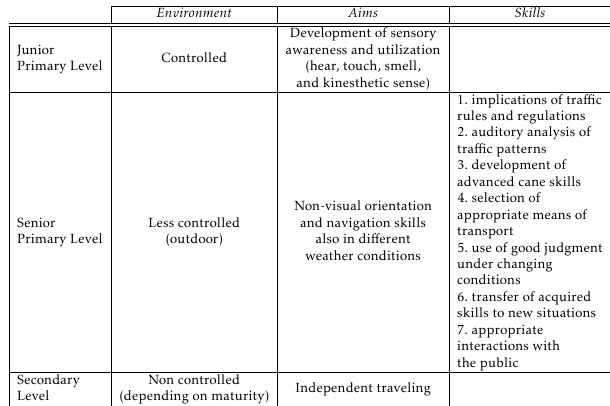
Table 1. The O&M training program of the CSEN (Hong Kong) subdivided in age